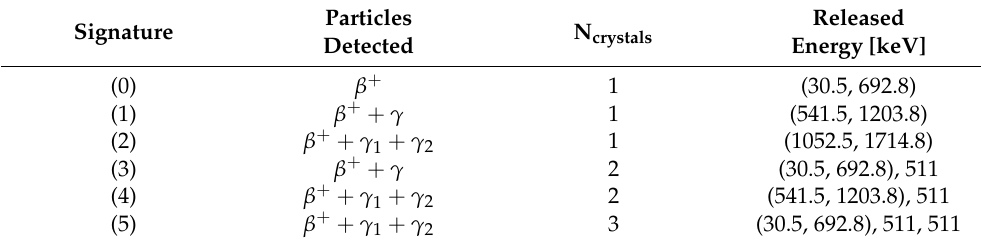
Table 2. List of 120 Sn β + EC decay scenarios within Cuoricino detector. For each signature we indicate the particles detected (positron and gammas), the number of bolometers involved and the